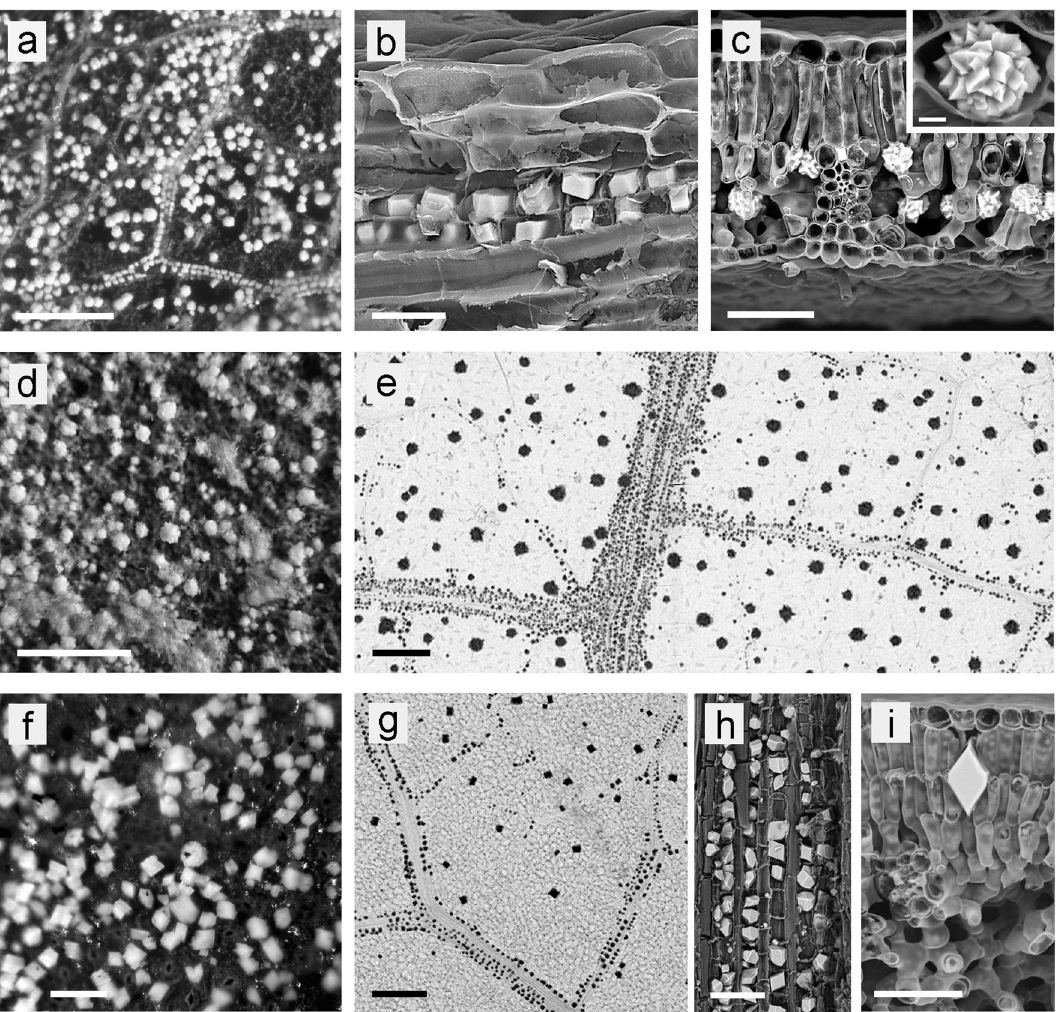
Figure 1. CaOx crystals and druses in leaves of extant plants. ( a , d , f ) LM images of the ash of carefully incinerated leaves show their distribution in a planar view. ( b , c , h , i ) SEM images of freeze-fractured leaves show crystal and druse morphology in detail. ( e , g ) Micro-CT images of CP-dried leaves. ( a – c ) Quercus robur ; high density of druses (15–25 µm) in the areoles and prismatic crystals along the veins. ( d ) Hedera helix ; leaf densely filled with druses of varying size. ( e ) Juglans regia ; large druses (50–70 µm) in areoles, and small druses along veins. ( f ) Prunus laurocerasus ; high density of prismatic crystals (20–30 µm) everywhere. ( g – i ) Parrotia